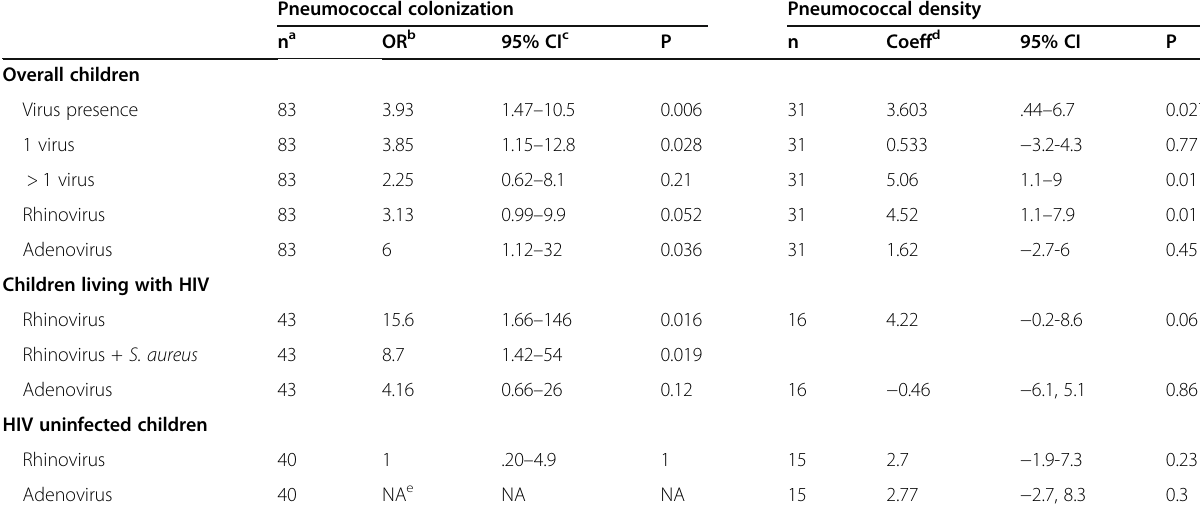
Table 5 Association between isolation of Streptococcus pneumoniae with respiratory viruses, and, between the density (Log copies/ ml) of Streptococcus pneumoniae with viruses in the nasopharynx of